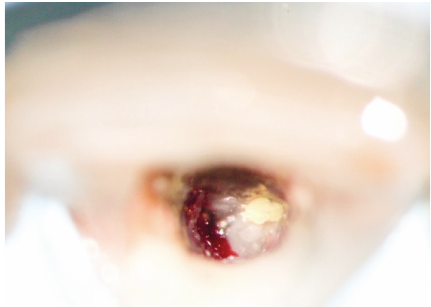
Figure 5: Access cavity with granuloma (left) and failed root filling (right).